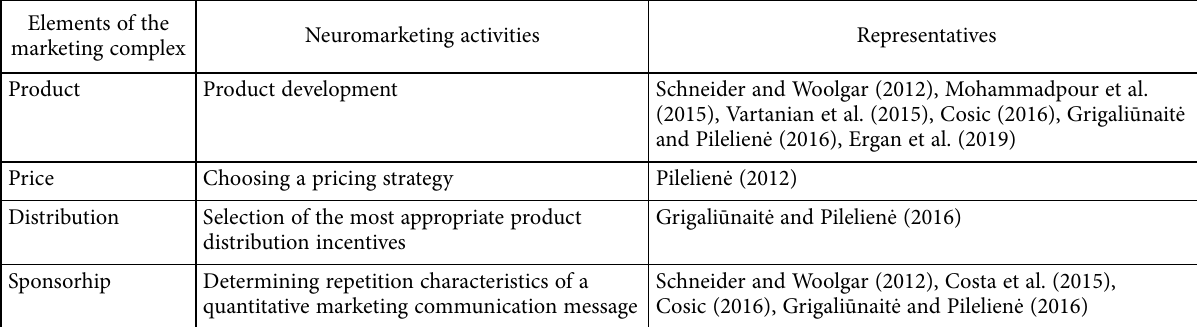
Table 5. Classification of neuroscience application fields according to elements of mareting complex Elements of the marketing